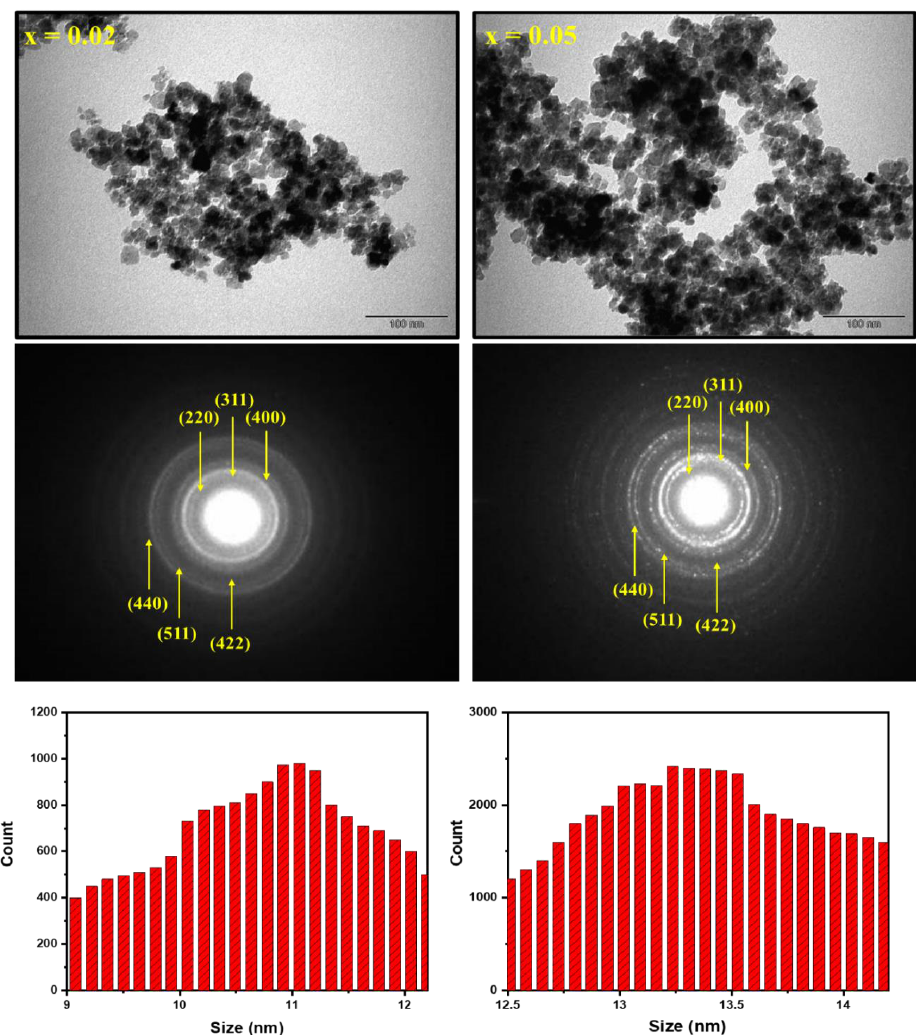
Figure 4. TEM, SAED, and size distribution histograms of (Co 0.5 Ni 0.5 )[Tm x Tb x Fe 2 − 2x ]O 4 NSFs with x = 0.02 and 0.05.